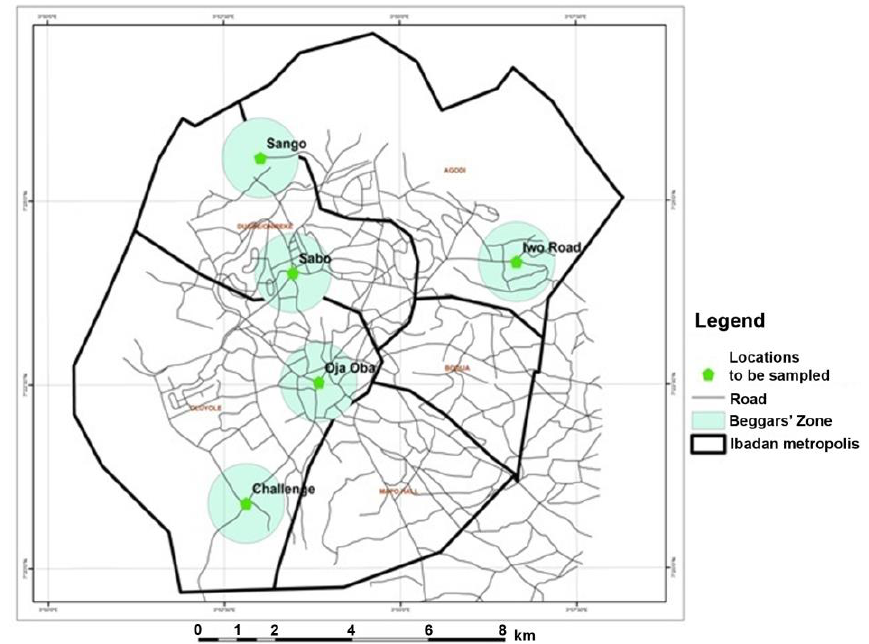
Fig. 3. Map of Ibadan metropolis indicating the locations of able-bodied beggars' (Source: Author’s device,